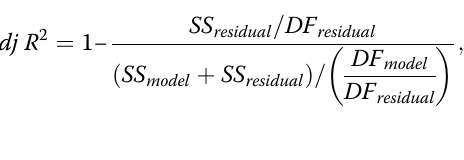
Table 2 Experimental factors and levels used for the optimum Ni (II) removal onto rGO-X-25 Factors (Independent variables)